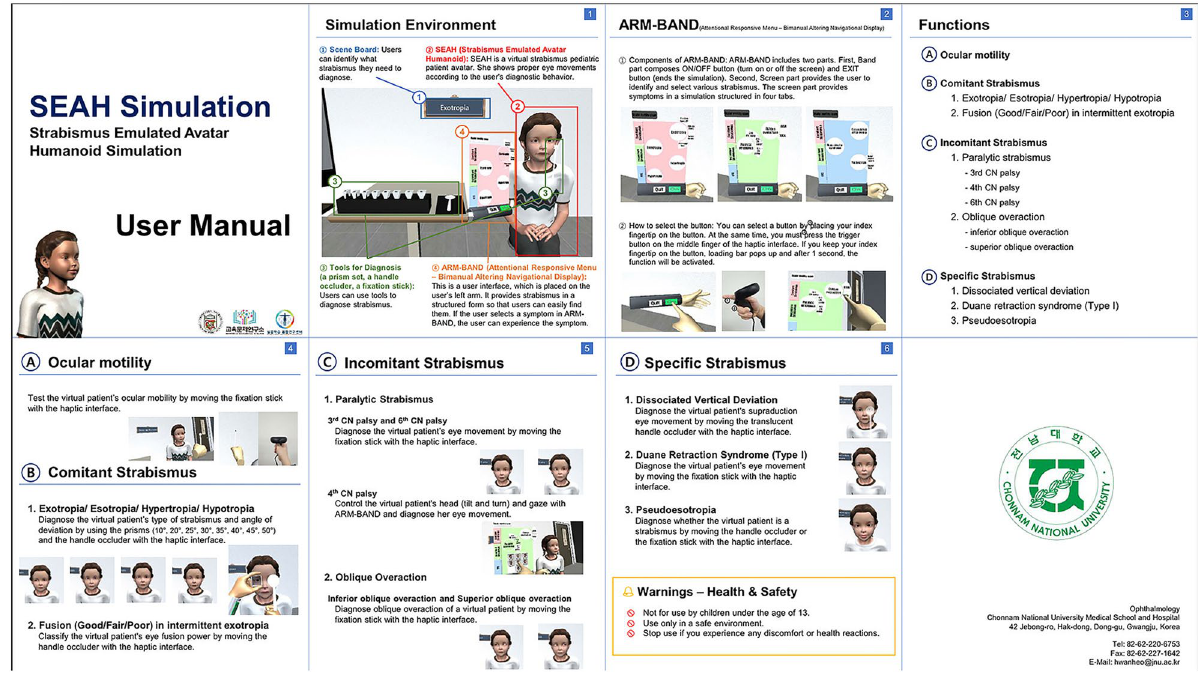
Figure 1. The user manual of the virtual reality application for diagnostic training of strabismus. The manual, which contains 8 pages, describes the simulation environment and the user interface implemented on the left wrist. The user interface provides lists of examinations that can be performed through simulation and how to carry them